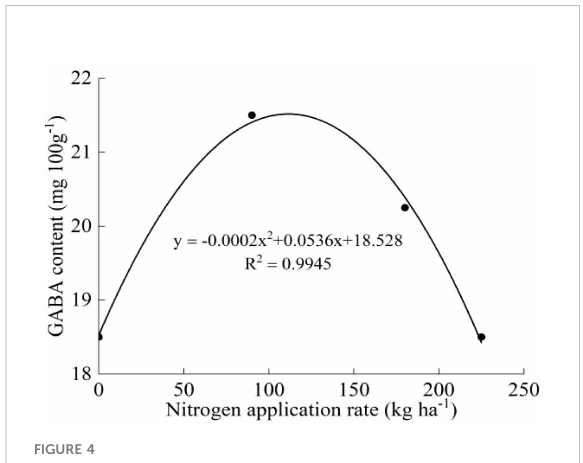
FIGURE 4 Relationship between J20 GABA content and nitrogen application